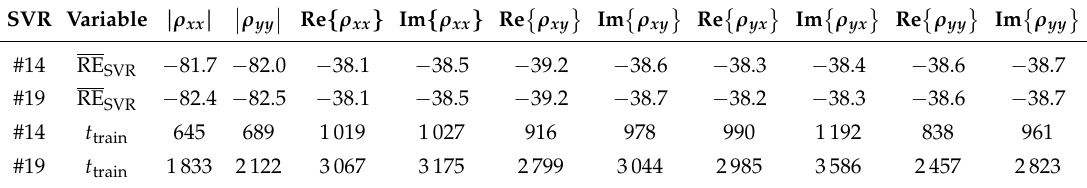
Table 3. Average relative error over the test set and training time of the SVR model with N r = 0.7 N for each output variable. N for Discretization #14 is 65,000, while for 2D SVR Discretization #19 is 190,000. The average test error RE SVR is in dB while the training time t train is in